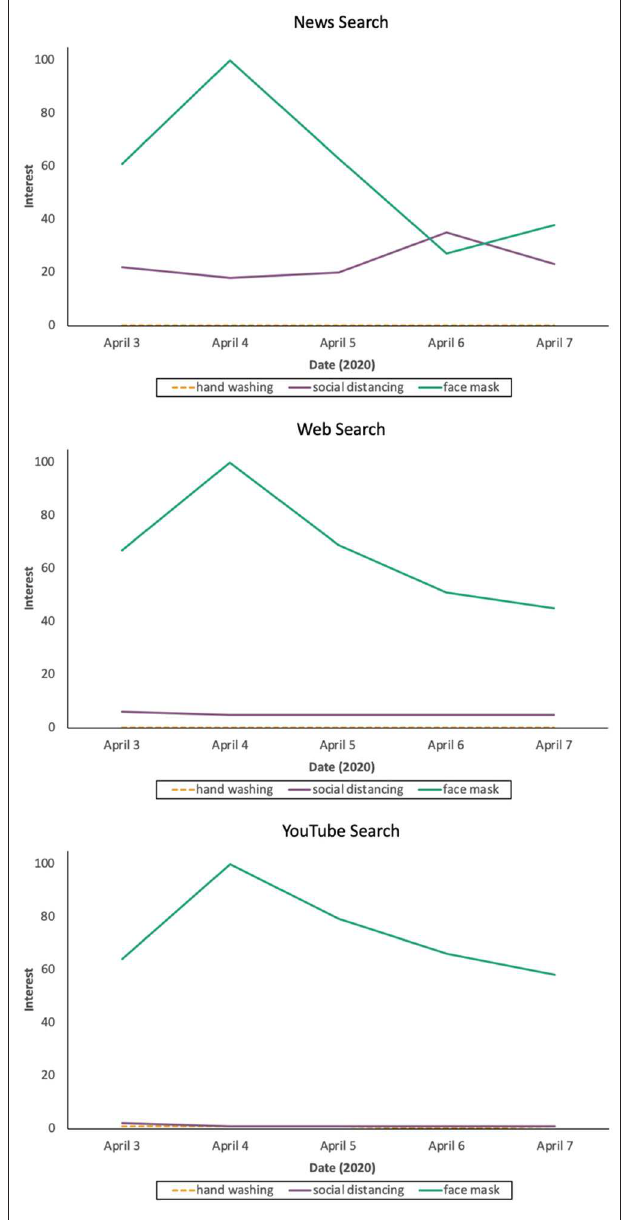
FIGURE 2 | Google Trends over time in news, web, and YouTube searches. Date range corresponds to the dates our survey was fielded. Scores of 100 represent peak interest over the chosen time period, whereas a score of 50 represents half the interest. For more information about Google Trends, or to explore other search terms, see